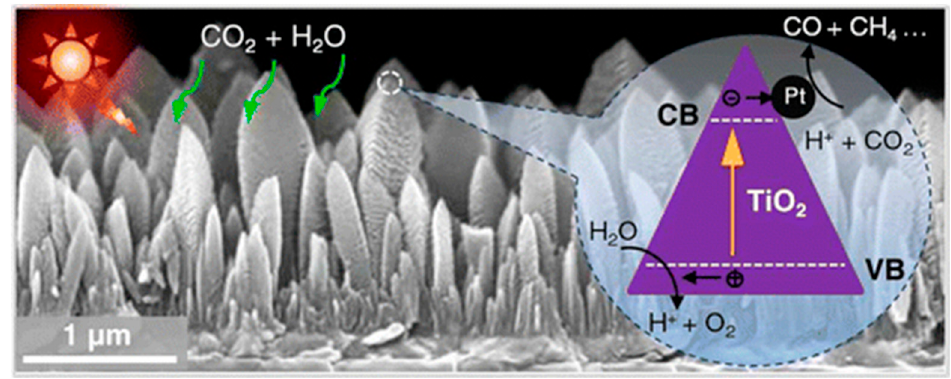
Figure 10. Enhanced CO 2 photoreduction efficiency by ultrafine Pt nanoparticles deposited on TiO 2 crystals. Reproduced from work in [91]. Copyright 2012 American Chemical Society.